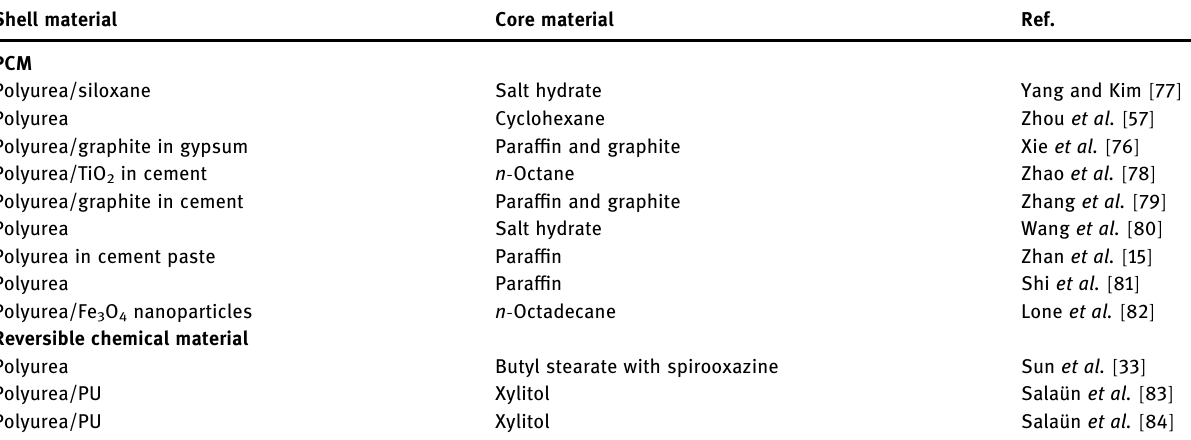
Table 2: Application of polyurea micro - /nano - capsules as energy storage materials Shell material